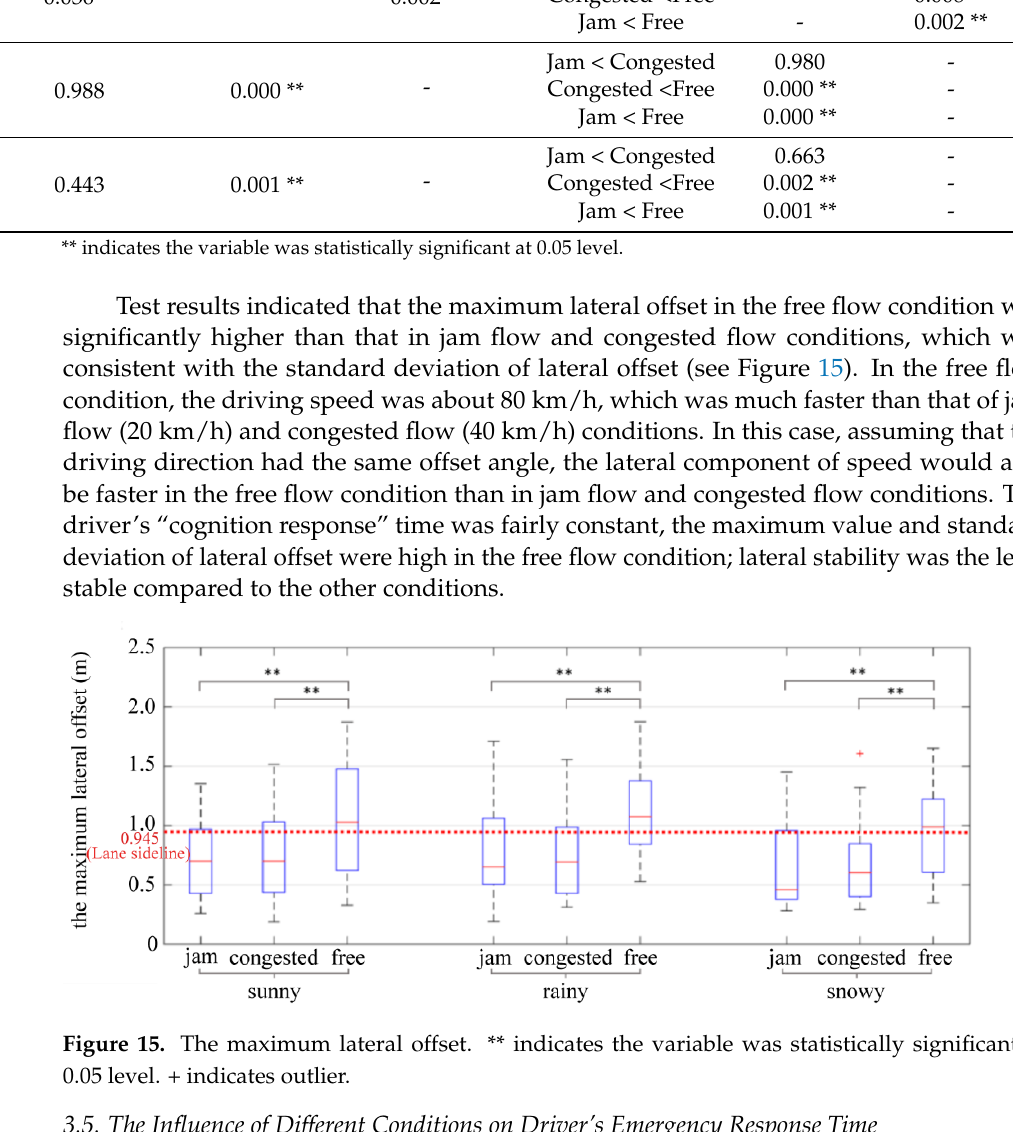
Table 13. Significance test of the influence of traffic flow on “time to half speed”.